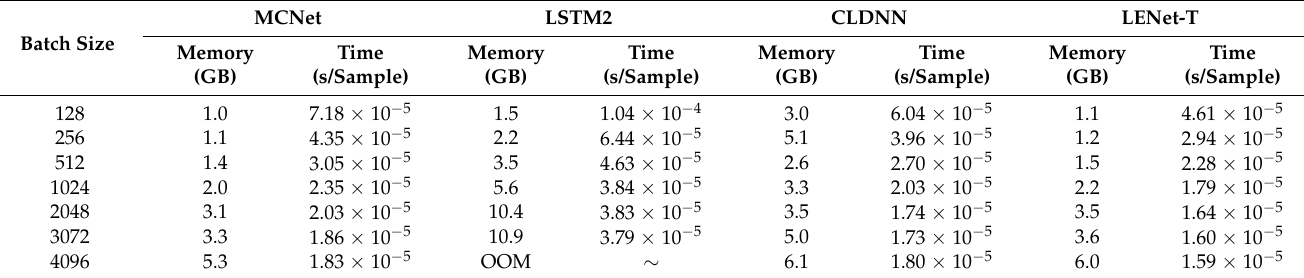
Table 10. The effect of different batch sizes on inference speed on the P4 platform. Memory indicates the memory usage of a single GPU graphics card. OOM stands for out of memeory. Time represents the average inference time for a single sample.